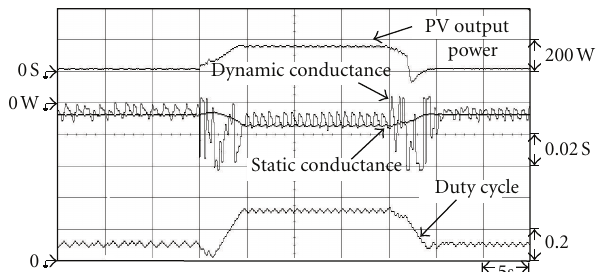
Figure 19: Measured output power, dynamic conductance, static conductance, and duty cycle waveforms of a PV module array using the variable step size INC method under irradiation that increased from 450 W/m 2 to 750W/m 2 and then dropped back to 450 W/m 2 .